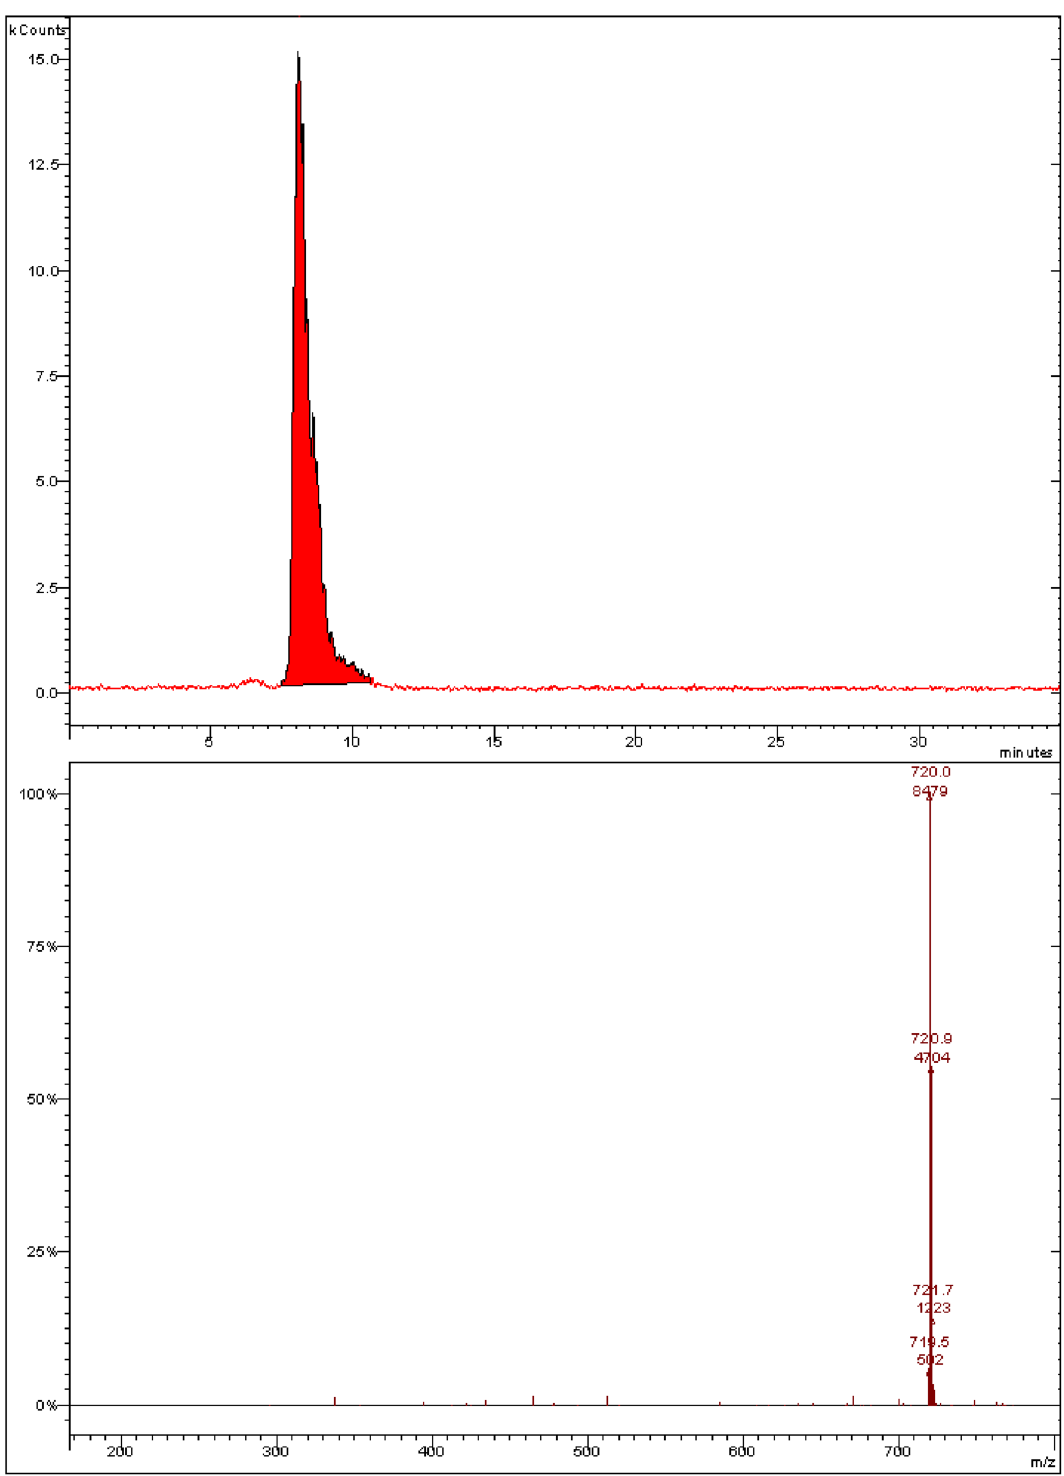
Figure 9. HPLC–MS chromatogram of C 60 interacts to a greater extent with the hydrophobic hydrocarbon chains of carboxylic acid residues as compared with the atoms of the glycerol backbone and oxygen atoms of carbonyl groups. This is due to the hydrophobicity of hydrocarbon groups and fullerene. The residues of oleic and palmitic acids create a connected network for a sufficient movement of a fullerene molecule in olive oil. Density field of oleic residues is presented in Fig. 11. The energy parameters of a simulated structure are presented in Table 2.